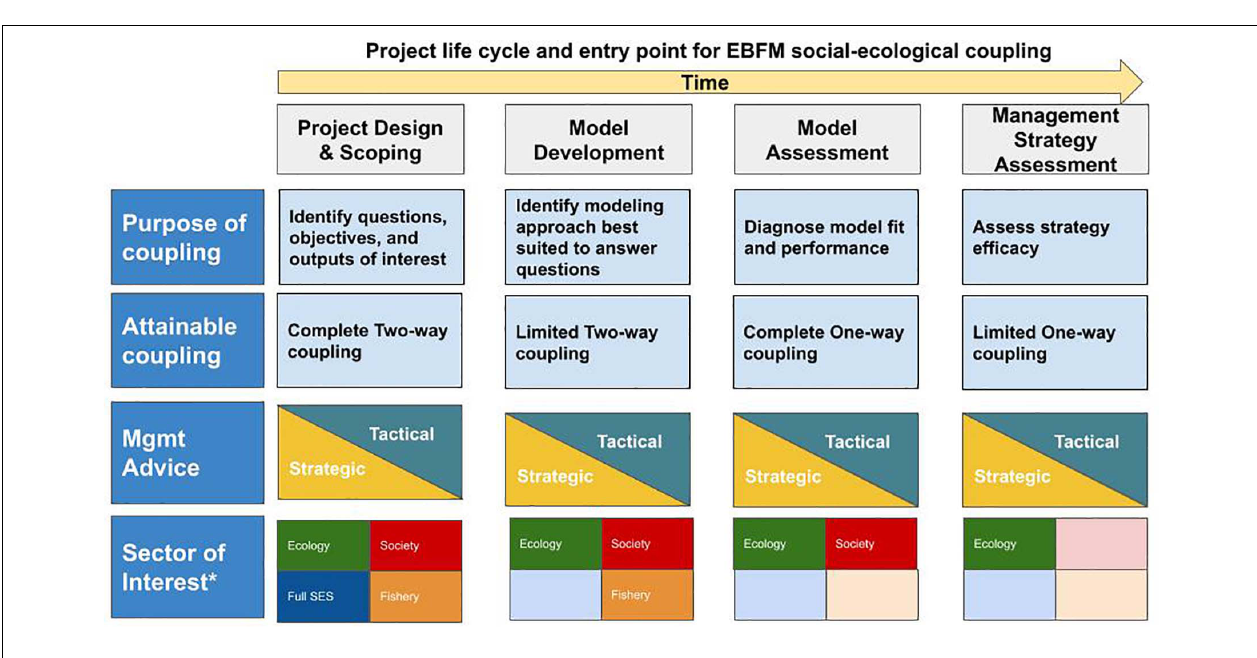
FIGURE 2 | Project life cycle and entry point for EBFM social-ecological coupling. *Note: The four sectors of interest for management questions are Understanding Ecosystem Connections and Function (shorthand “Ecology”), Assessing the Impact of Environmental and Management Changes on Fisheries (shorthand “Fisheries”), Understanding the Distributional Impacts of Management Policies and Environmental changes on Society and the Economy (shorthand “Society”), and a Full SES Approach Integrating the other Three Sectors (shorthand “Full SES”).